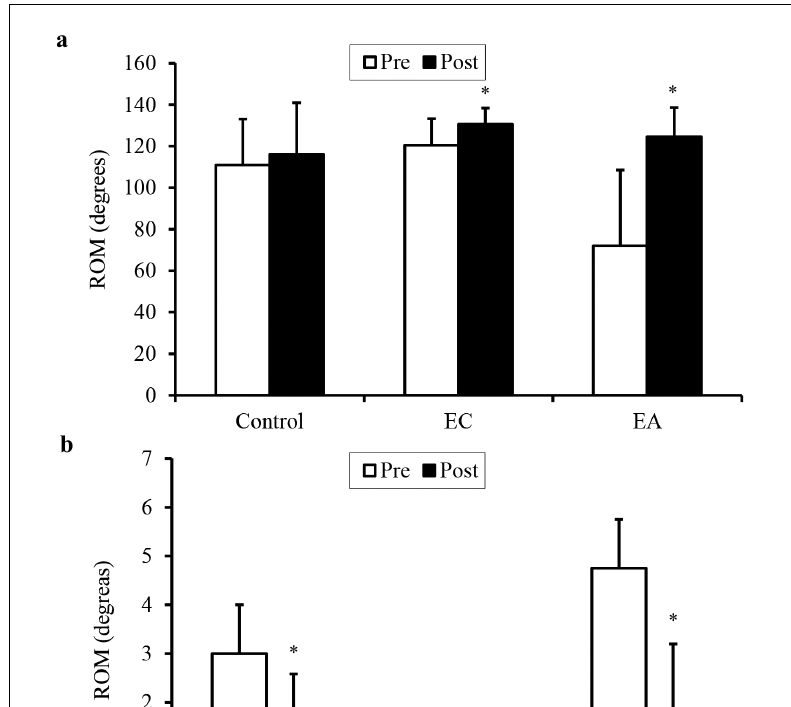
Note. * p < .05 comparing to pre intervention value.